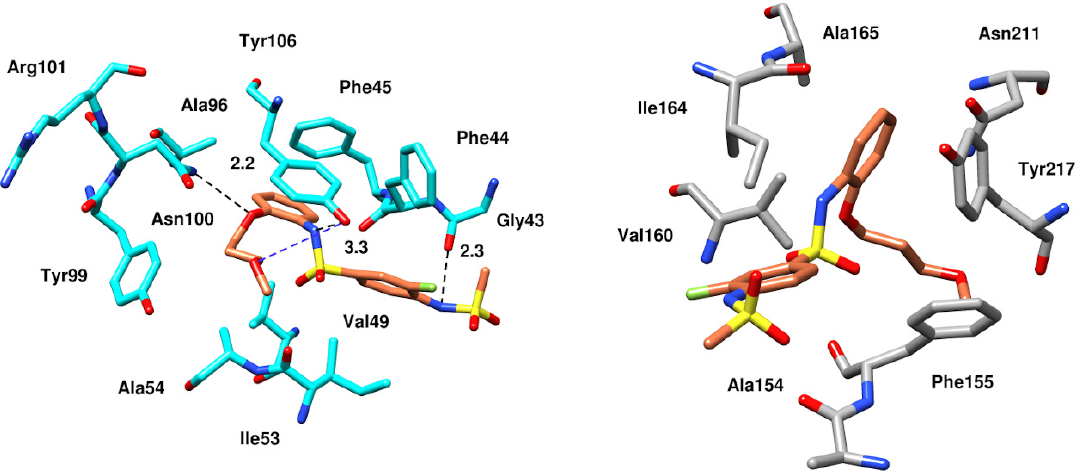
Figure 7. Molecular docking interactions of the binding pockets residues of BRD9 (cyan) and BRD7 (gray) with ZINC433599781 [17].